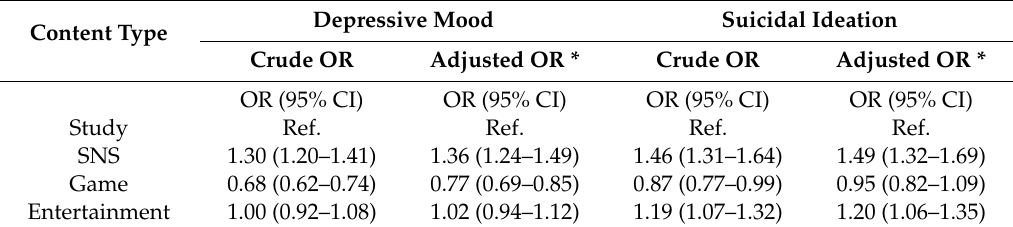
Table 4. Multivariable logistic regression analysis of content type of smartphone use, for depressive mood and suicidal